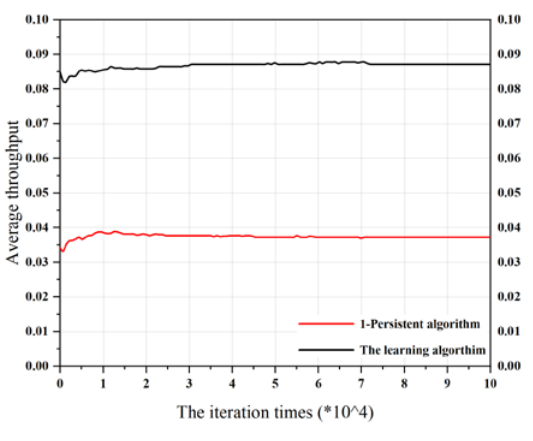
Fig. 1. The average throughput of the learning algorithm and the 1-Persistent algorithm under attacks with three